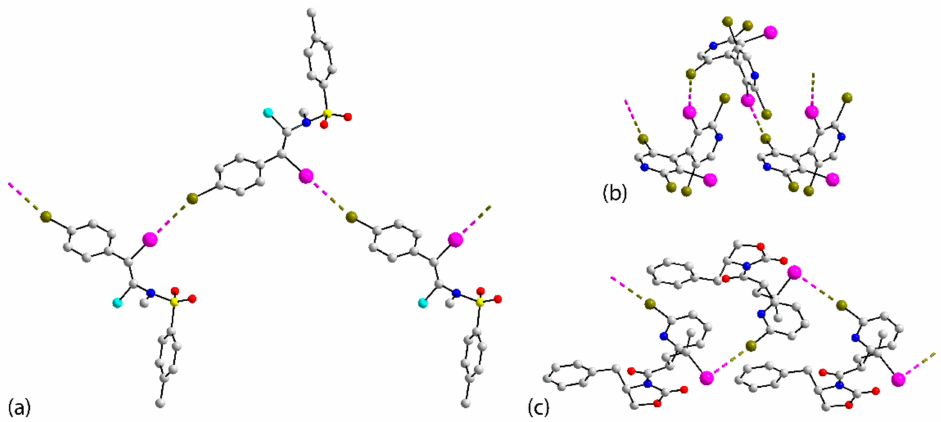
Figure 9. One-dimensional, helical chains in the crystals of ( a ) 27 , ( b ) 31 and ( c ) 33 .